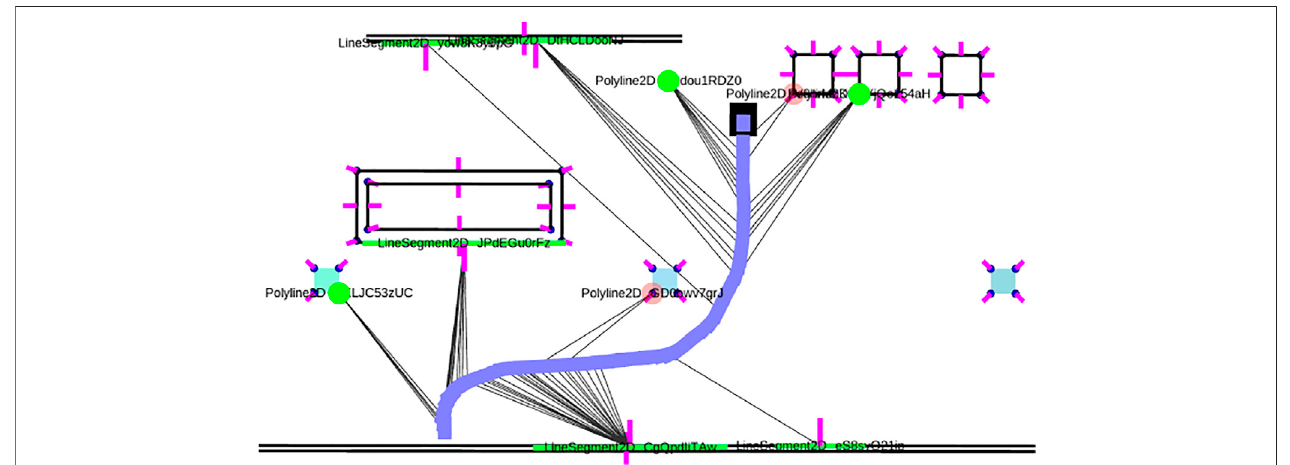
FIGURE16| Thelocalmapoffeatures(green)alignedagainsttheglobalmap,whichservesasapriorusingnearestneighbordataassociations.Theresultingrobot trajectoryistheMAPestimateoftherobotposesintheglobal map.Weused thismethod toobtainthegroundtruthestimatesforourtrajectoriestoverifyourhypothesis approach. The robot trajectory is indicated by the blue line and the green and red circles and lines indicate